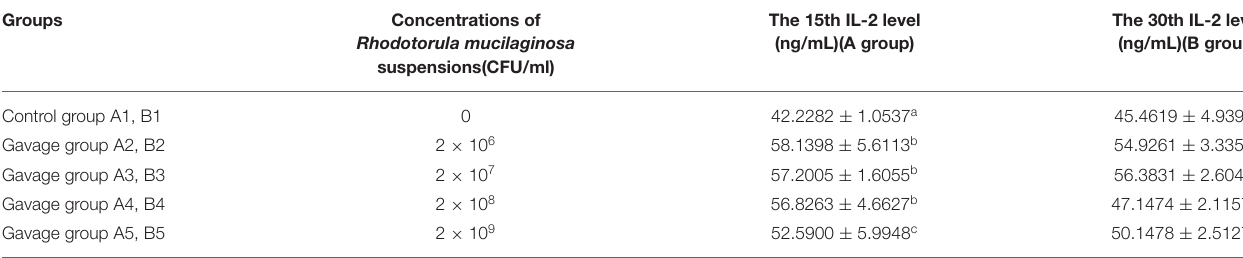
TABLE 5a | Effects of R. mucilaginosa on IL-2 content in mouse serum. Groups